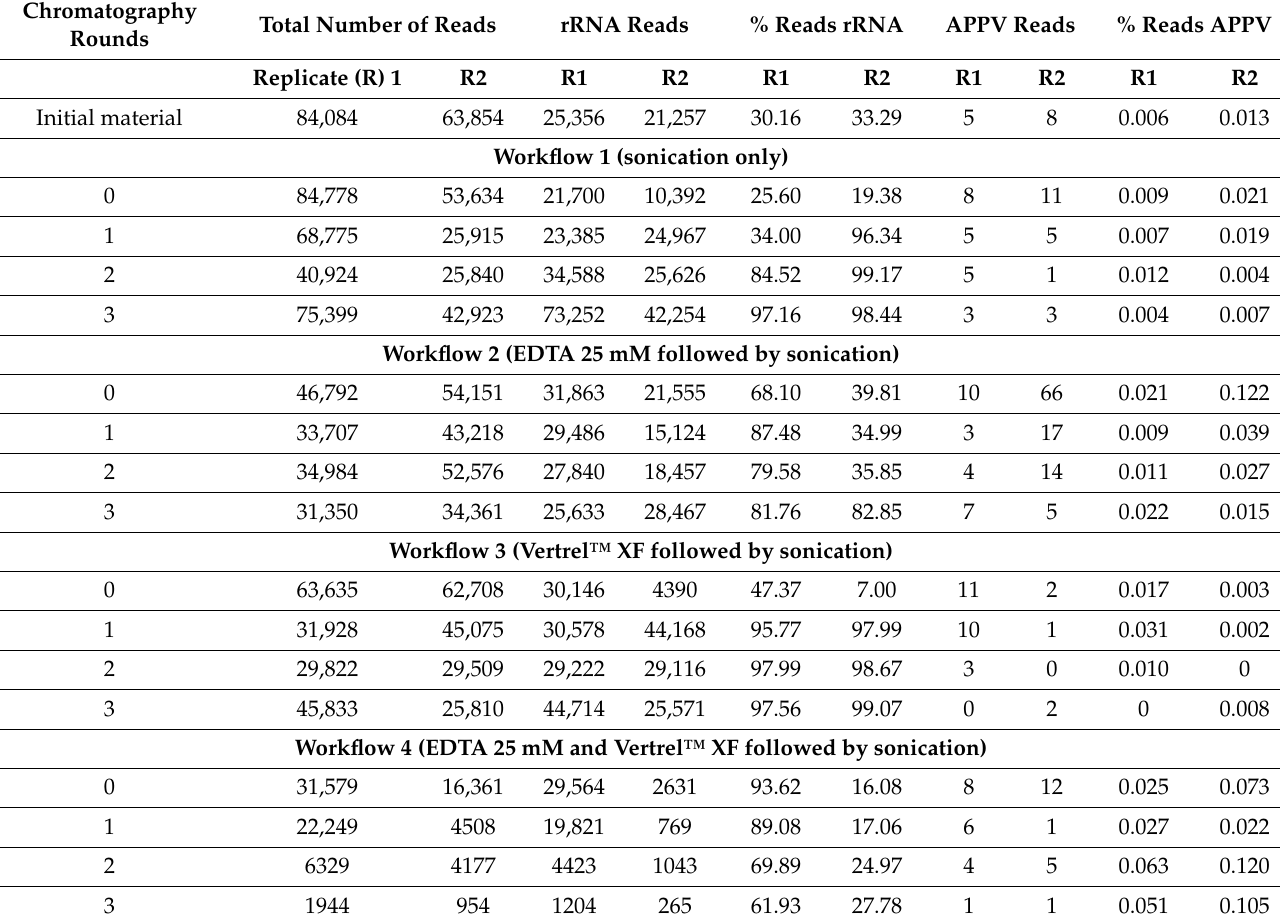
Table 3. Sequence reads of 18s RNA, 28s RNA, and APPV in VIDISCA-NGS libraries after sample processing and enrichment with the different